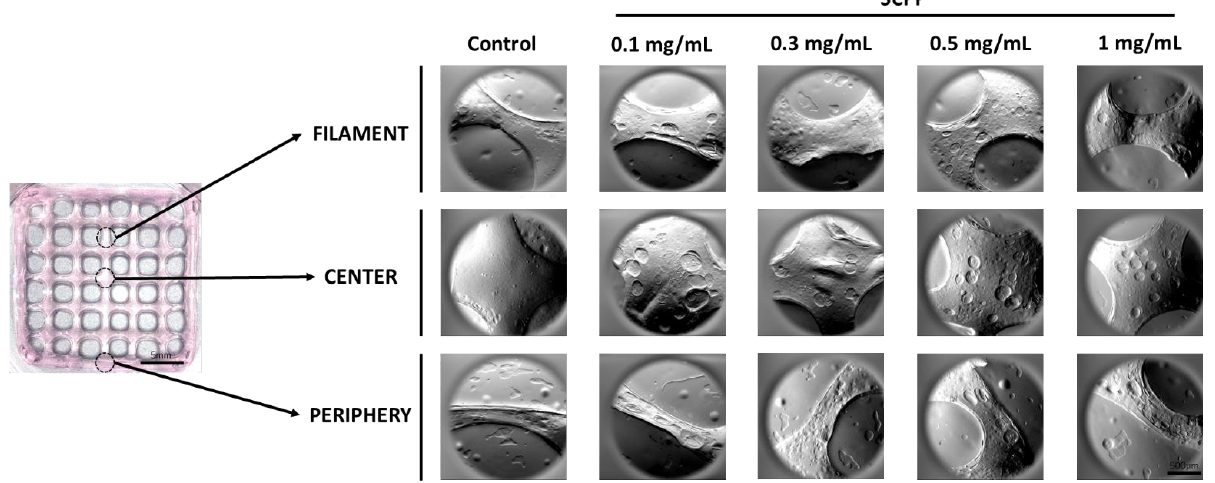
Figure 3. The crosslinked scaffold was segmented into three regions: the center, filament, and periphery. The SEM micrographs for these three regions of interest were captured across the control, 0.1, 0.3, 0.5, and 1 mg/mL groups. The surface morphology appeared to be consistent throughout the